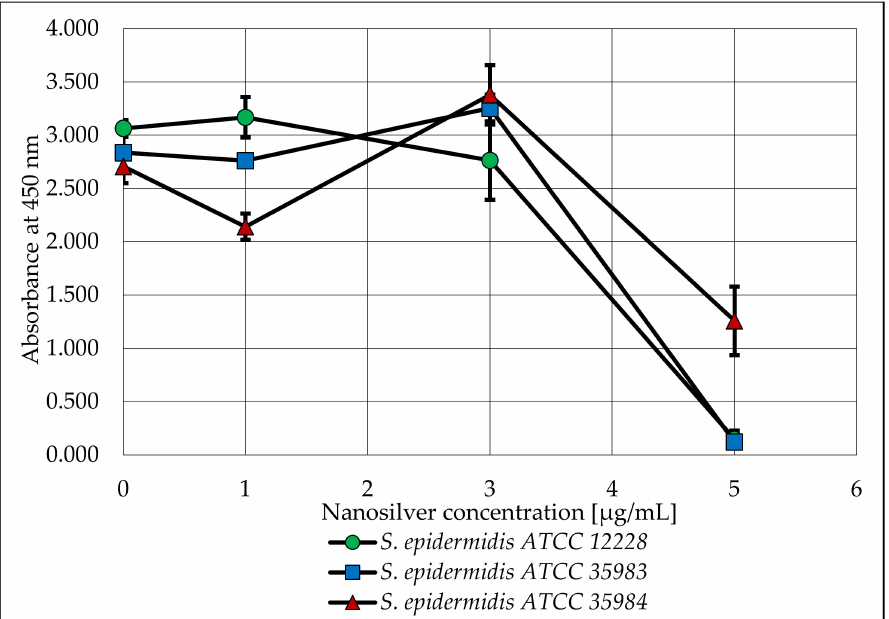
Figure 5. Analysis of the viability of S. epidermidis bacteria, depending on the concentration of nanosilver used. Error bars indicate standard